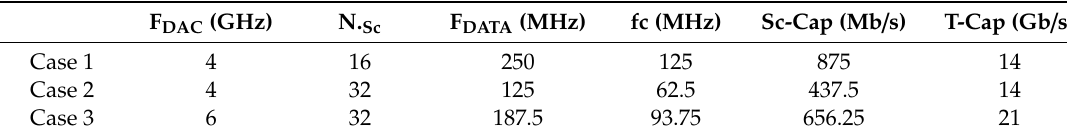
Table 1. Comparison of expansion trials for multi-carrier OGFDM